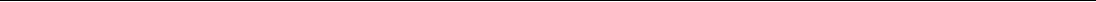
Fig. 6 The protein landscape of cancer immunotherapy in DGC. a Multiple receptor – ligand pairs found in antigen-presenting cells (APCs) and T cells ( fi gure adapted from ref. 45 and ref. 46 ). Shade of the each of the three blocks represents the percentage of patients with the protein overexpressed in PX1 – 3, respectively, and the number above the block denotes the total percentage of all patients with the protein overexpressed. b Expressions of 19 immunotherapy targets in clinical development. The y -axis of the box plots at the bottom represents log 10 (FOT ×10 5 ) of each protein; the number in parenthesis in the x -axis represents number of patients with FOT > 10 − 5 . T1 – 3 tumor tissues of PX1 – 3; N1 – 3 nearby tissues of PX1 – 3. The box plots show the median, 25th and 75th percentile values (horizontal bar, bottom and top bounds of the box), and whiskers show the 1.5-fold IQR. c Comparison of various parameters among three clusters. Patients in PX1 (blue), PX2 (orange), and PX3 (red) are ordered by mutation numbers. * P < 0.05, ** P < 0.01, *** P < 0.001 (Chi-square test), IDO immunohistochemistry staining of representative examples (bottom, shown at ×100 magni fi cations, scale bar: 100 μ m), their IHC scores, the corresponding FOT ×10 5 values obtained from protein pro fi ling, and IDO1 protein expression measured by western blot are shown. IT-TILs intratumoral tumor-in fi ltrating lymphocytes, CD8+T-high CD8-positive T-cell number ≥ 298 per μ m 2 (see Supplementary Figure 6d for details), MSI-H microsatellite instability high, EBV Epstein – Barr virus status; IDO1/ARG1-high ≥ upper quartile of all detected values. d H&E and CD8 IHC staining in representative examples in PX1 – 3, shown at ×100 magni fi cation (scale bar: 200 μ m)*P < 0.05, **P < 0.01, *** P < 0.001 (Chi-square